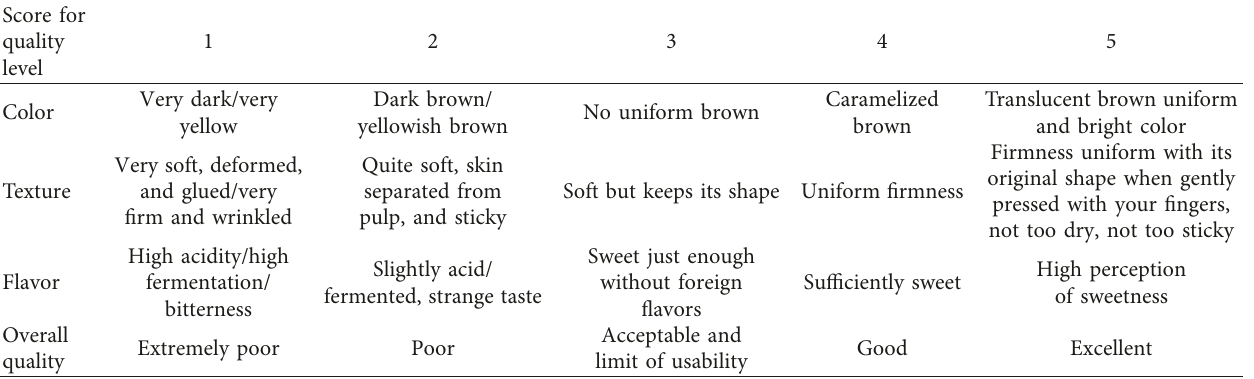
Table 2: Guide of sensory evaluation for date